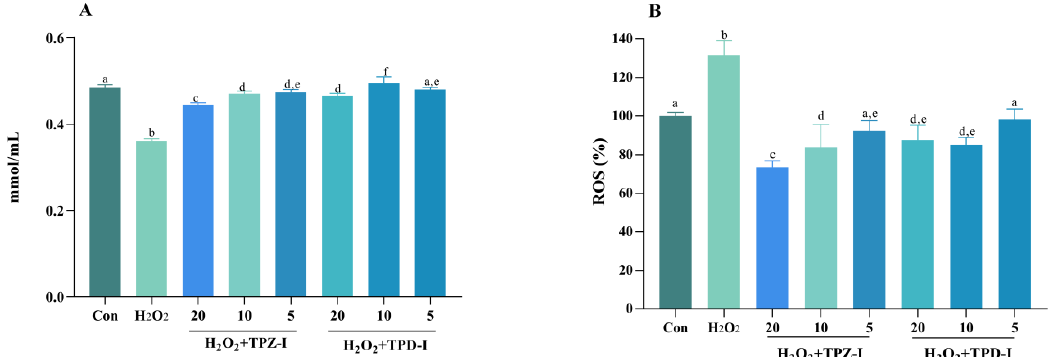
Figure 5. Effects of TPZ-I and TPD-I on the activities of total antioxidant capacity-T-AOC ( A ), and reactive oxygen species-ROS ( B ) in IPEC-J2 cells. The concentrations of the polysaccharide fractions were 20, 10, and 5 μg/mL, respectively. Values are presented as means ± SD ( n = 6). Bars with different letters are statistically significant ( p < 0.05).